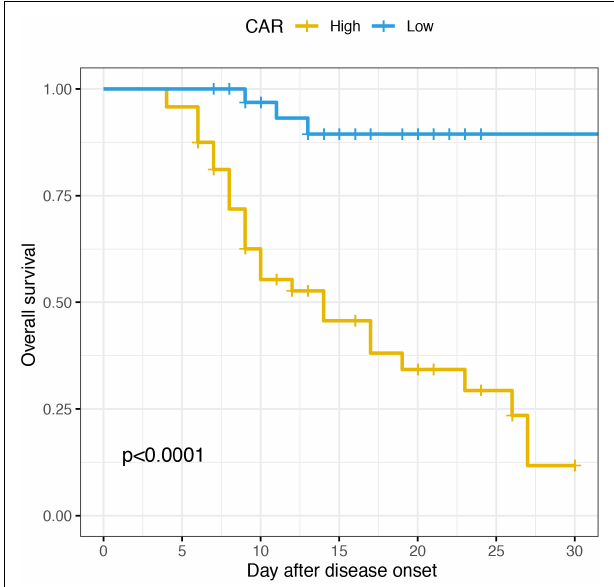
FIGURE 6 | KM survival curve for overall survival in SFTS patients stratified according to CAR.